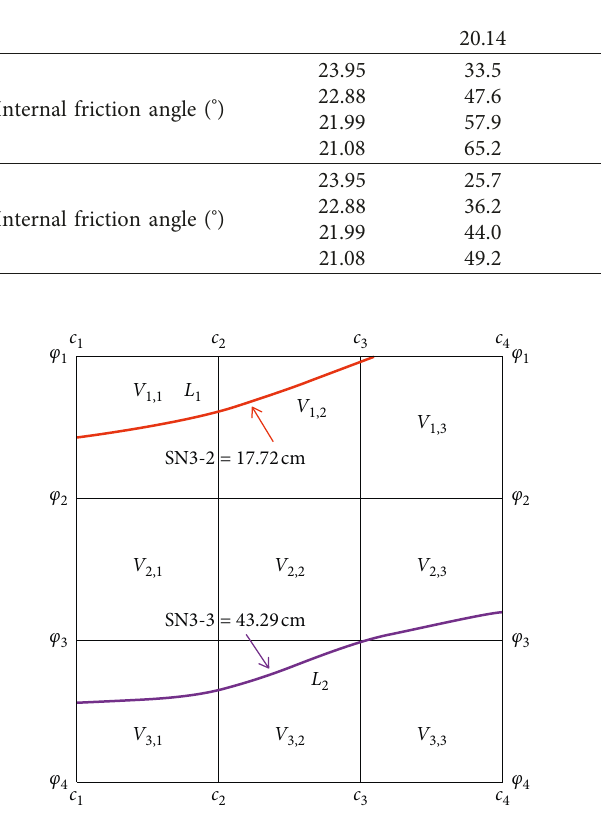
Figure 7: Conceptual diagram of deformation with strength